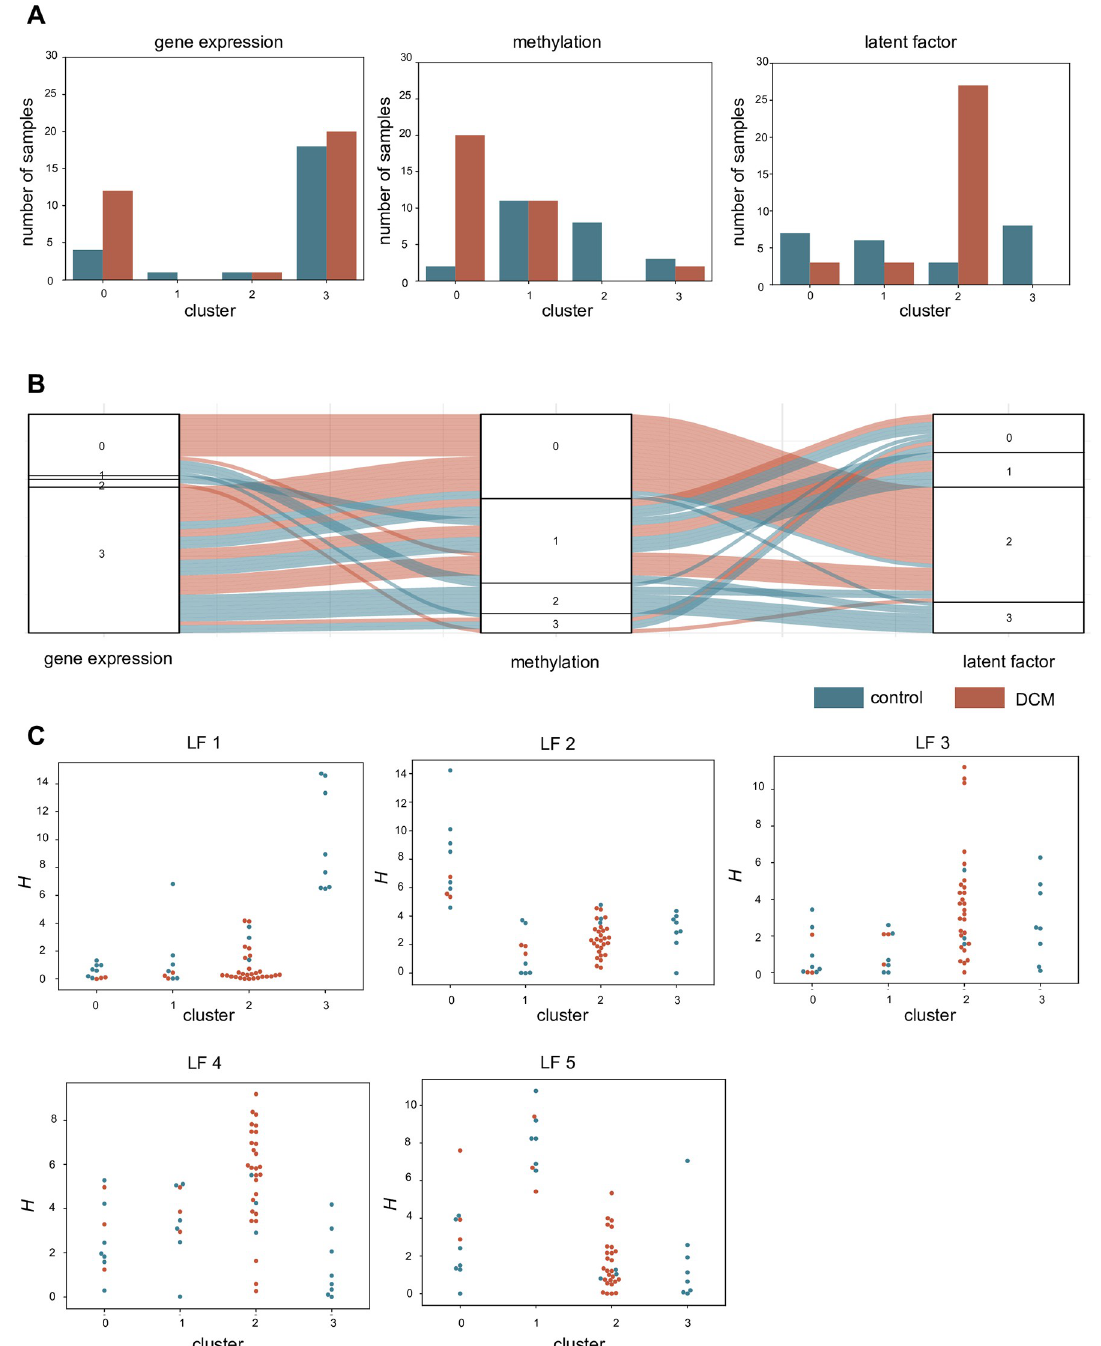
Fig 2. Clustering of the samples with latent factor profile. A) Clusters obtained using the k-means algorithm at k = 4 for the gene expression data matrix, methylation data matrix and latent factor profile. Clusters 0, 1, 2 and 3 are plotted on the X-axis and Y-axis represents the number of control and DCM samples in each cluster. B) A Sankey-flow diagram depicts the flow of samples between the 4 clusters as per the gene expression, methylation and latent factor profile. We see that as per the latent factor profile, several DCM samples (27) are binned into cluster 2. C) Swarm-plots depicting the value of five latent factors for samples in each cluster as obtained by the latent factor profile show which samples have an over-expression of that particular latent factor. We see that for cluster 2 in which DCM samples predominate, have a high value for latent factors 3 and